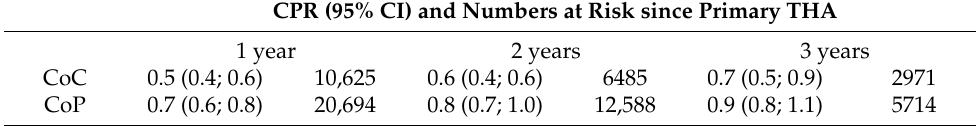
Table 2. Cumulative probability of revision (CPR) after propensity score matching (PSM) at 1:2 for PJI comparing CoC and CoP.